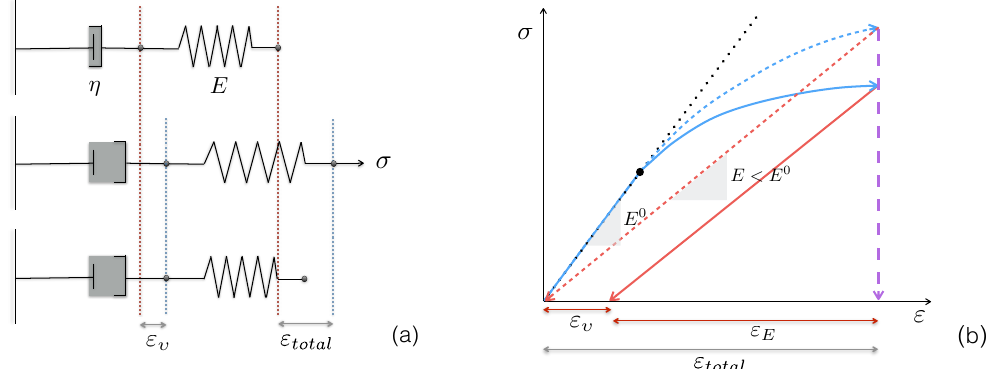
Figure 1. (a) Schematic representations of the Maxwell model for a continuum material with elastic (shear) modulus E and viscosity η . At time t , a stress is applied on the system. It is removed at time t + (cid:49)t : the spring goes back to its initial position but the dashpot retains its deformation ε υ . (b) Loading–unloading paths for a material with initial elastic modulus E 0 in the linear-elastic (dotted), EB (dashed) and Maxwell-EB (solid lines) model. The black dot indicates the onset of damaging in the EB and Maxwell-EB models. Unlike the EB model, the Maxwell-EB model allows the total deformation to be partitioned into a permanent ( ε υ ) and an elastic contribution ( ε E ), as indicated by the arrows along the deformation axis. The diagram is not to scale in the context of modelling the lithosphere or sea ice; in these geomaterials, permanent deformations can become much greater than elastic deformations as damage events accumulate over